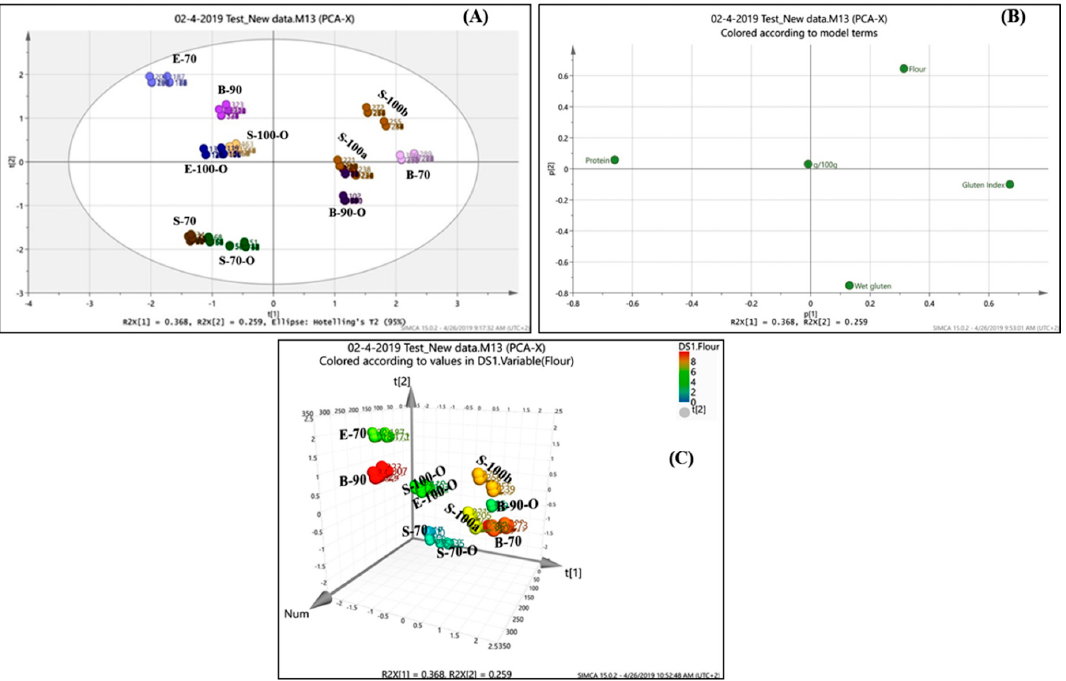
Figure 2. Principal components analysis of the studied amino acid profile and quality characteristics; ( A ) score plot and ( B ) loading plot and ( C ) 3D scatterplot (for the type studied cereal flour numbering, please see Table 1).